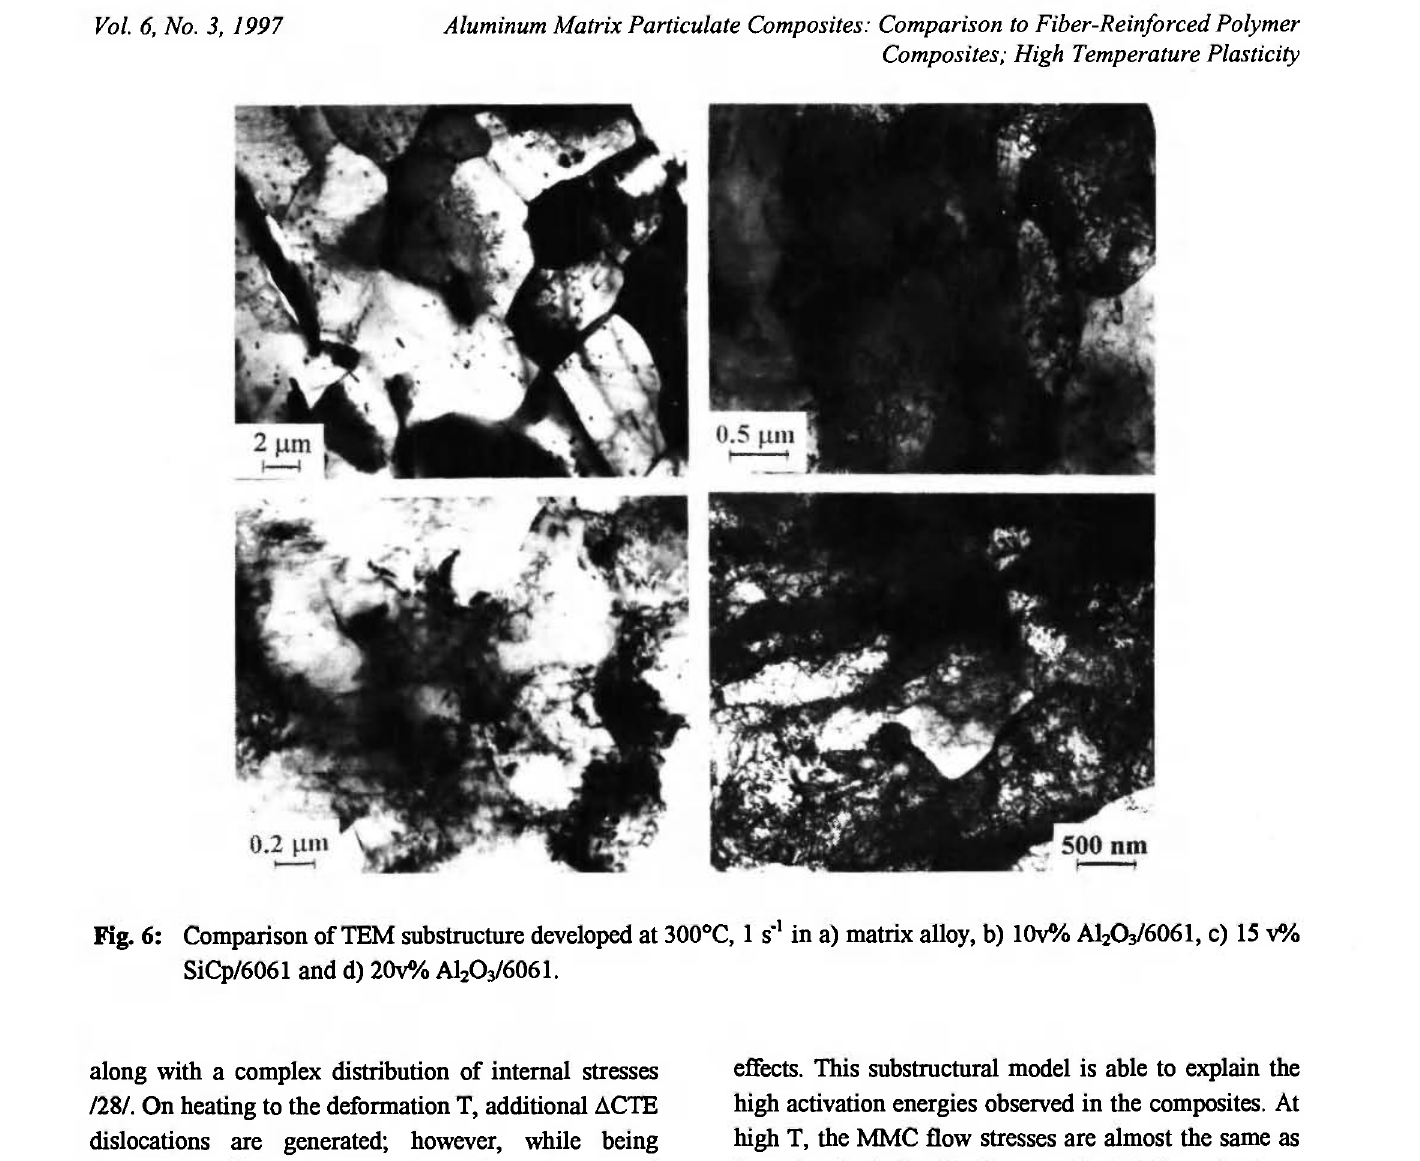
Fig. 6: Comparison of TEM substructure developed at 300°C, 1 s" 1 in a) matrix alloy, b) 10v% AI2O3/6O6I, c) 15 v% SiCp/6061 and d) 20v% Al 2